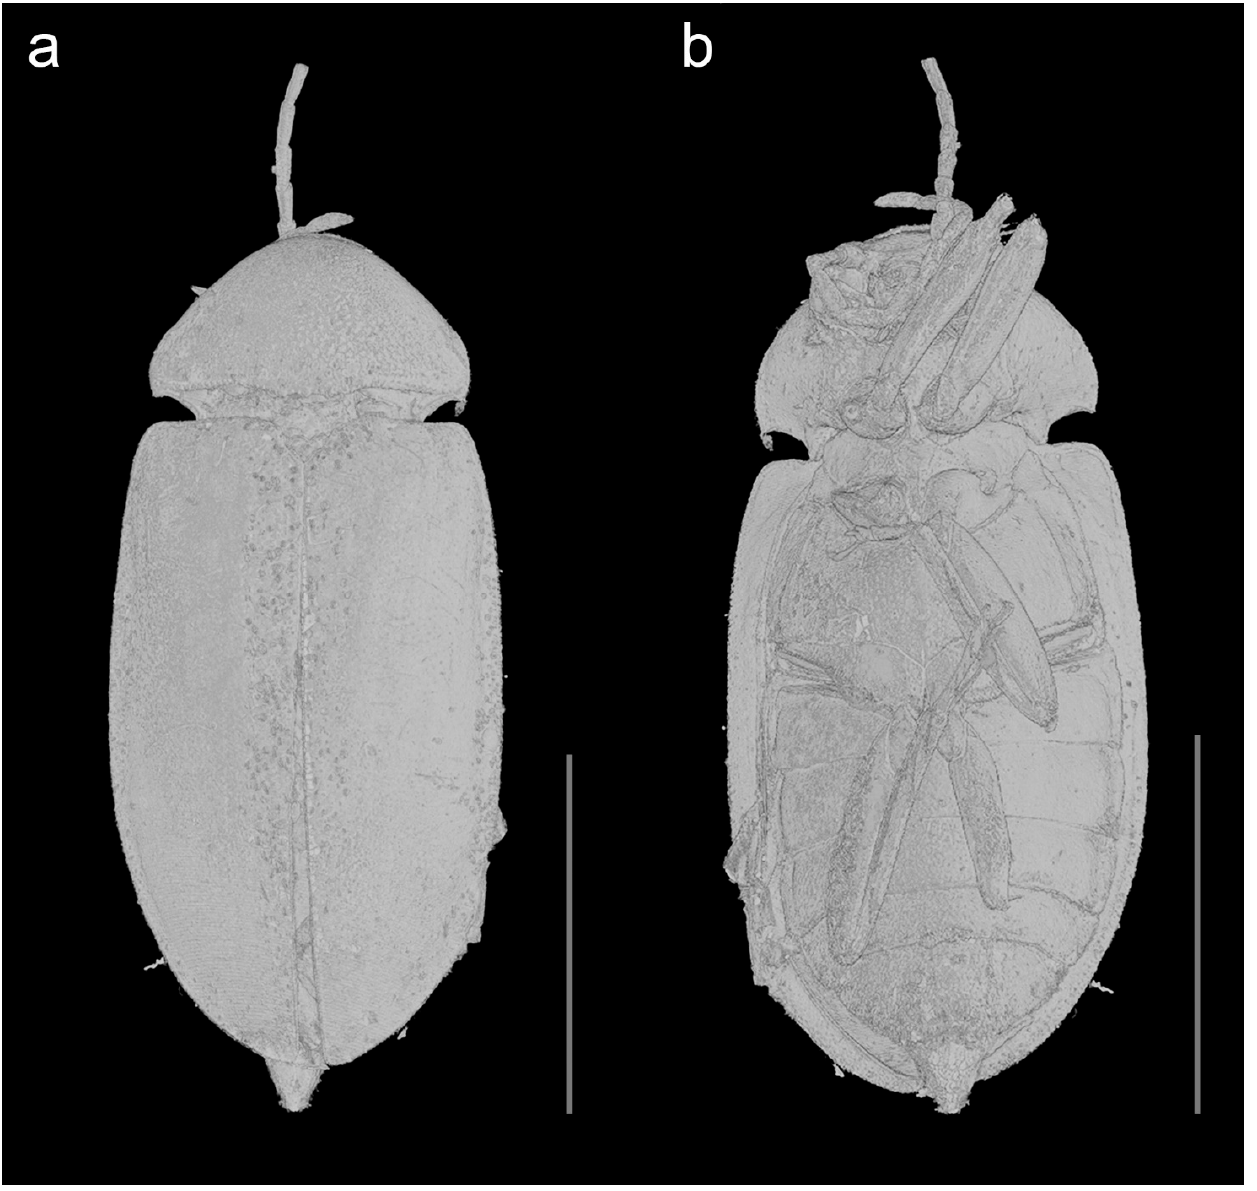
Figure 3. Ptilodactyla eocenica Kundrata, Bukejs and Blank, sp. nov., habitus. ( a ) Dorsal view; ( b ) ventral view. Scale bar = 4.0 mm.